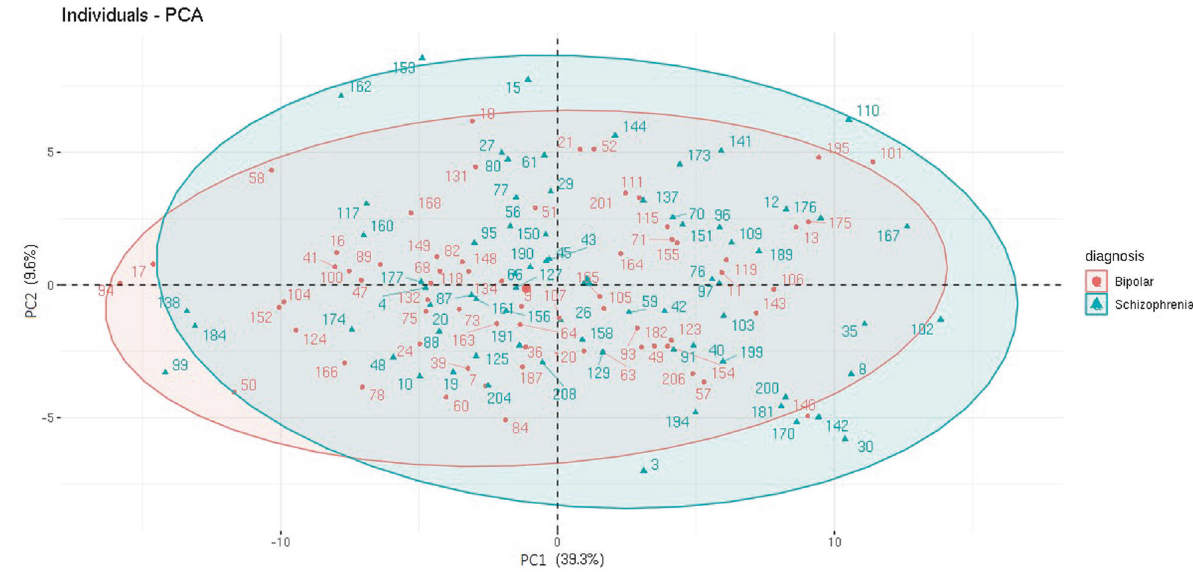
Fig. 2 PCA scores plot. Levels of serum proteins in individuals visualized by